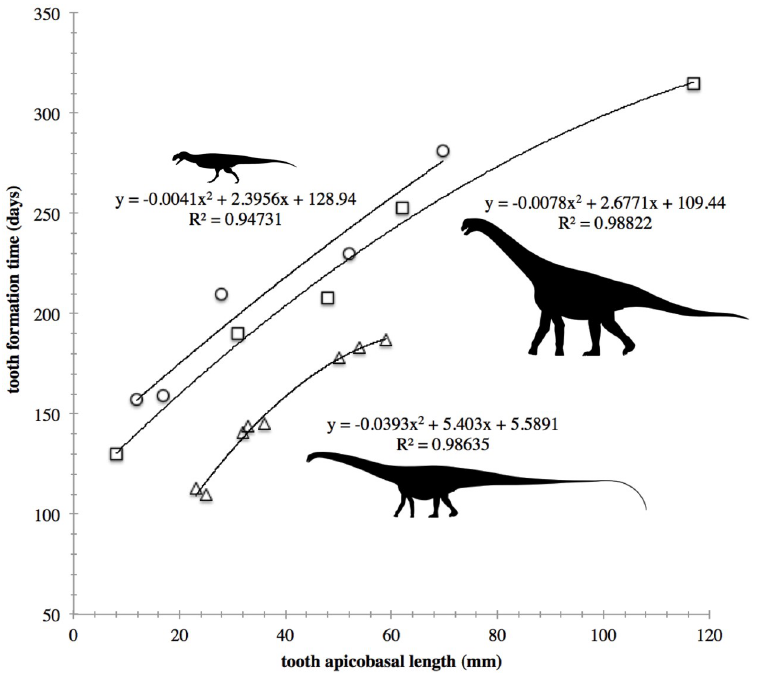
Fig 2. Models of tooth formation time. Tooth Formation time versus tooth apicobasal length for Diplodocus (triangles), Camarasaurus (squares), and Majungasaurus (circles). Sauropod data from [2]. Silhouettes by S. Hartman from